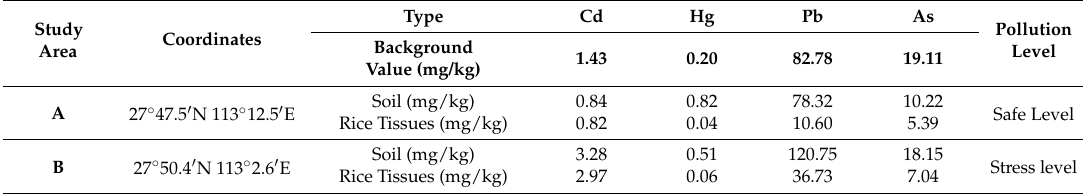
Table 1. Average heavy metal concentrations in the study